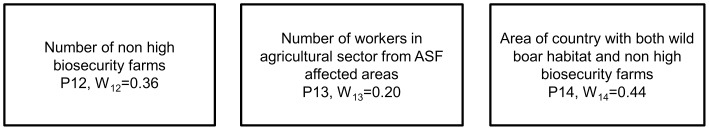
Structure of the exposure assessment model.Proxy indicators defined and their relative weights for the assessment of the exposure of ASF into the European Union via illegal importations of pork and pork products.